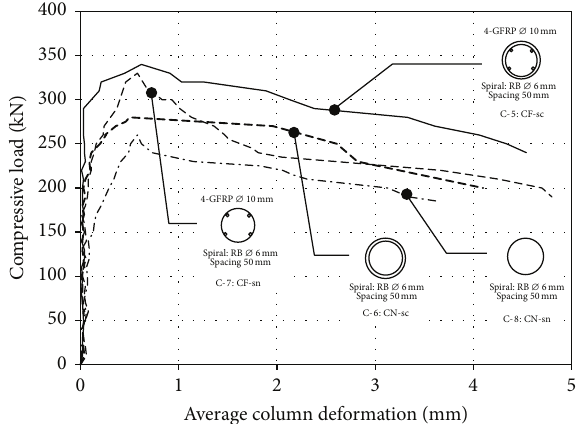
Figure 5: Load-deformation curves of circular